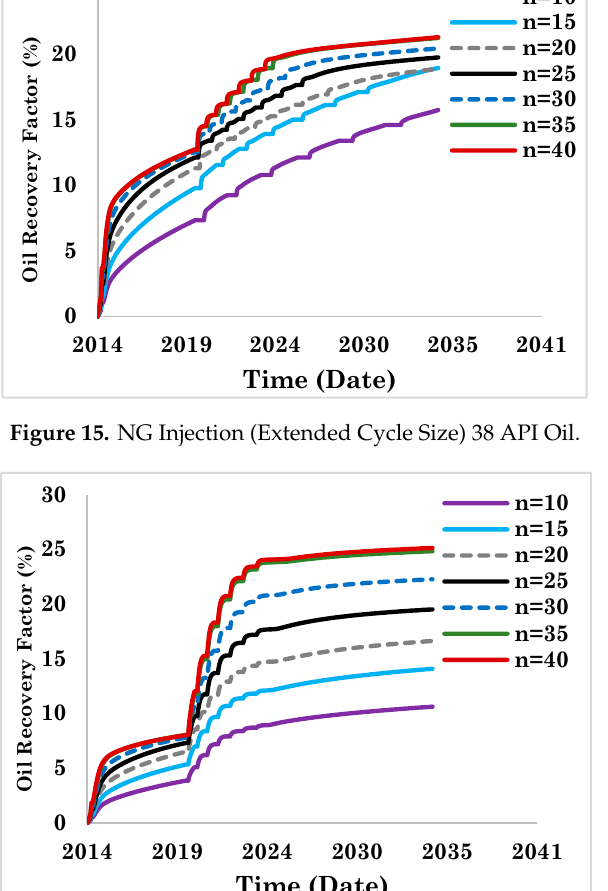
Figure 13. CO 2 Injection (Extended Cycle Size) 38 API Oil.